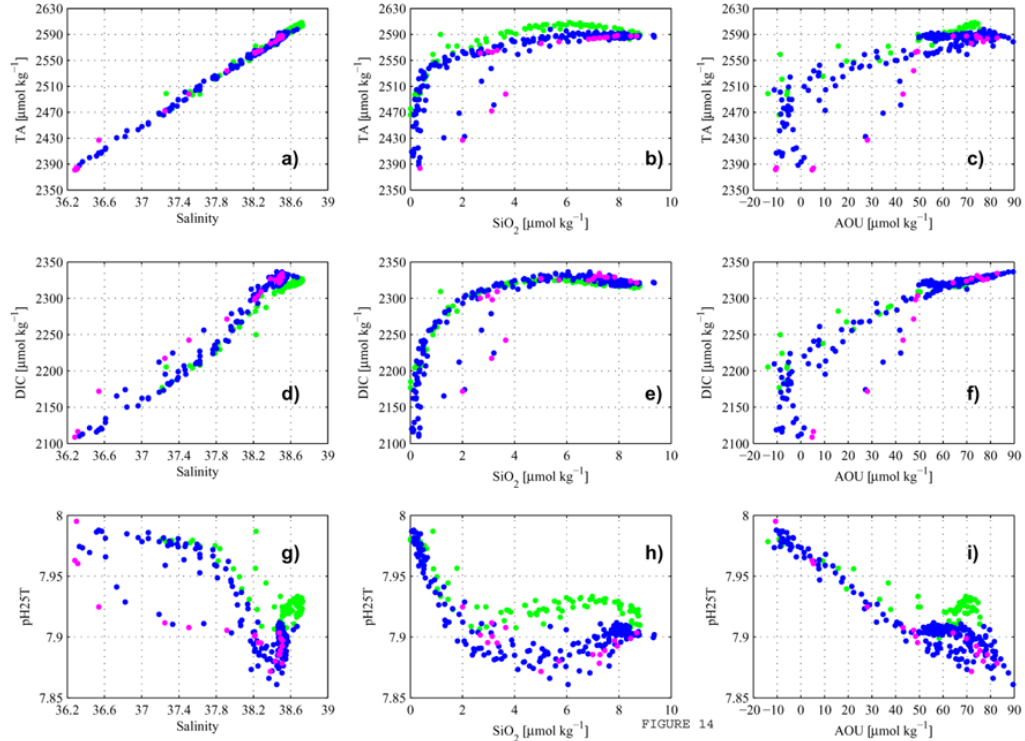
Fig. 14. Property-property plots for the M84/3 data in the western basin: Tyrrhenian Sea (green dots), Western basin (blue) and Strait of Gibraltar (magenta). First row: alkalinity (TA inµmolkg − 1 ) vs. (a) salinity, (b) silicate concentration (SiO 2 in µmolkg − 1 ) and (c) AOU (µmolkg − 1 ) . Second row: Dissolved Inorganic Carbon (DIC in µmolkg − 1 ) vs. (d) salinity, (e) SiO 2 and (f) AOU. Third row: pH25T vs. (d) salinity, (e) SiO 2 and (f) AOU. The station positions are shown in Fig. 1.